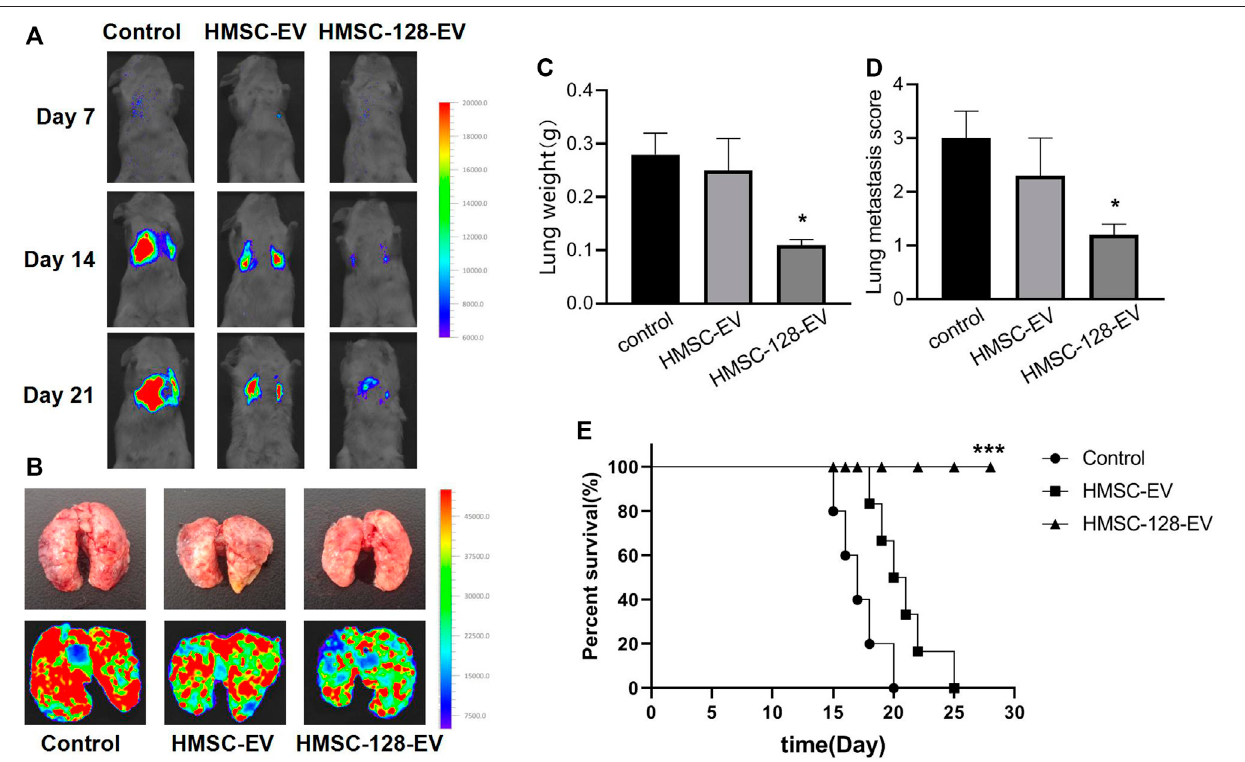
FIGURE 9 | HMSC-128-EV inhibited the metastasis of UCs and prolonged the survival time of nude mice. (A,B) typical images of live nude mice and lung fl uorescence imaging, respectively. (C,D) are the statistical results of lung tissue weight and the number of lung metastatic nodules in nude mice of each group, respectively. HMSC-128-EVcould signi fi cantly reduce the lungmetastasisofUCs innude mice. (E) isthesurvivalcurve ofnude mice ineach group. HMSC-128-EVcan signi fi cantly prolong the survival time of nude mice with UCs. * p < 0.05, *** p < 0.001 vs.